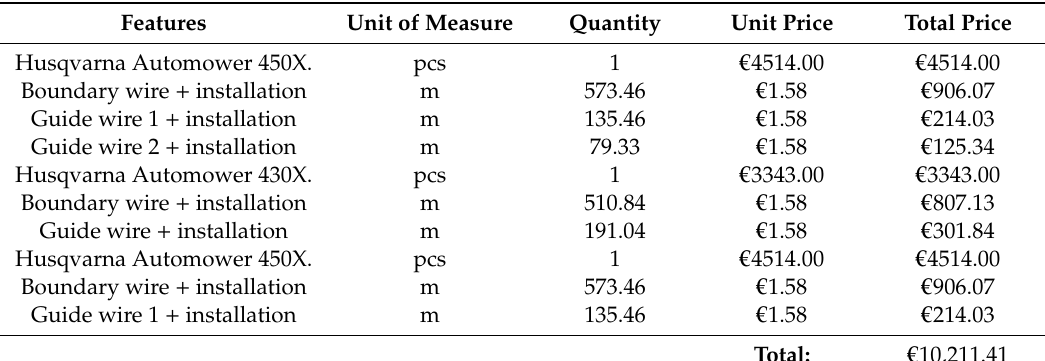
Table 5. Total cost of Scenario